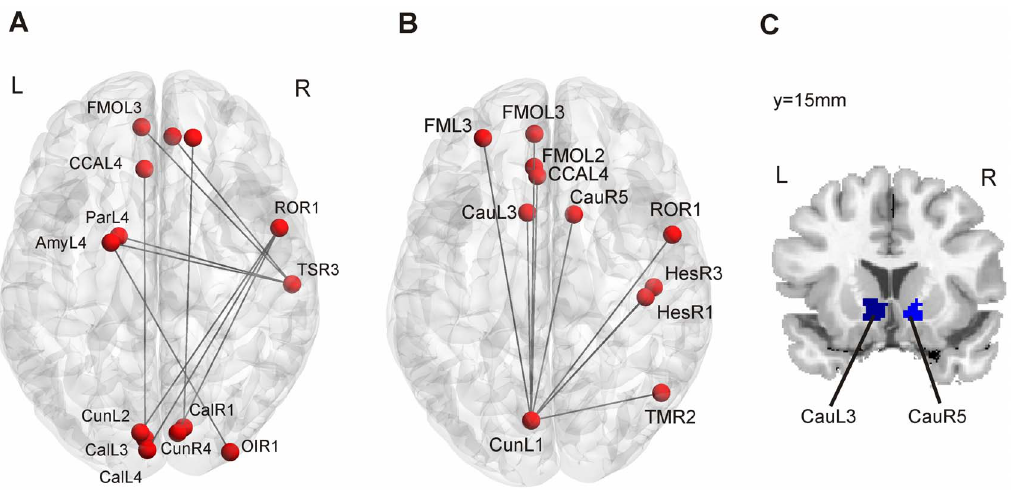
Figure 6. Altered connectivity of the visual network. A) Altered connectivity of nodes in module 4 (visual network). We observe stronger occipital-frontal and occipital-temporal connectivity for healthy controls. B) Altered connectivity of the cuneus node CunL1. C) Coronal view showing the anatomical location of the two caudate nodes CauL3 and CauR5. Abbreviations: Amy: Amygdala; Cal: Calcarine; Cau: Caudate; Cun: Cuneus; CCA: anterior cingulate cortex; FMO: medial orbitofrontal cortex; Hes: Heschl gyrus; OI: inferior occipital cortex; Par: parahippocampus; RO: rolandic